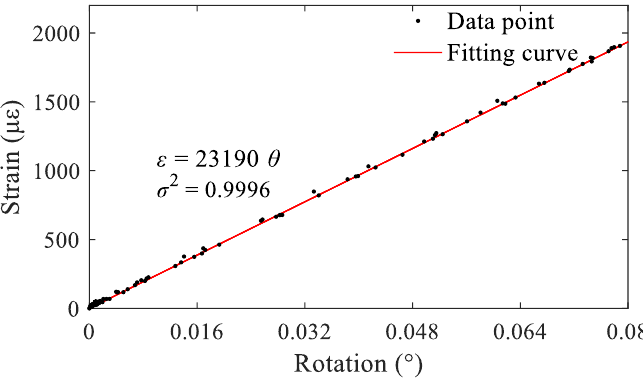
Figure 7. Strain and displacement curves under repeated load ( a ) strain curve; ( b ) displacement curve.